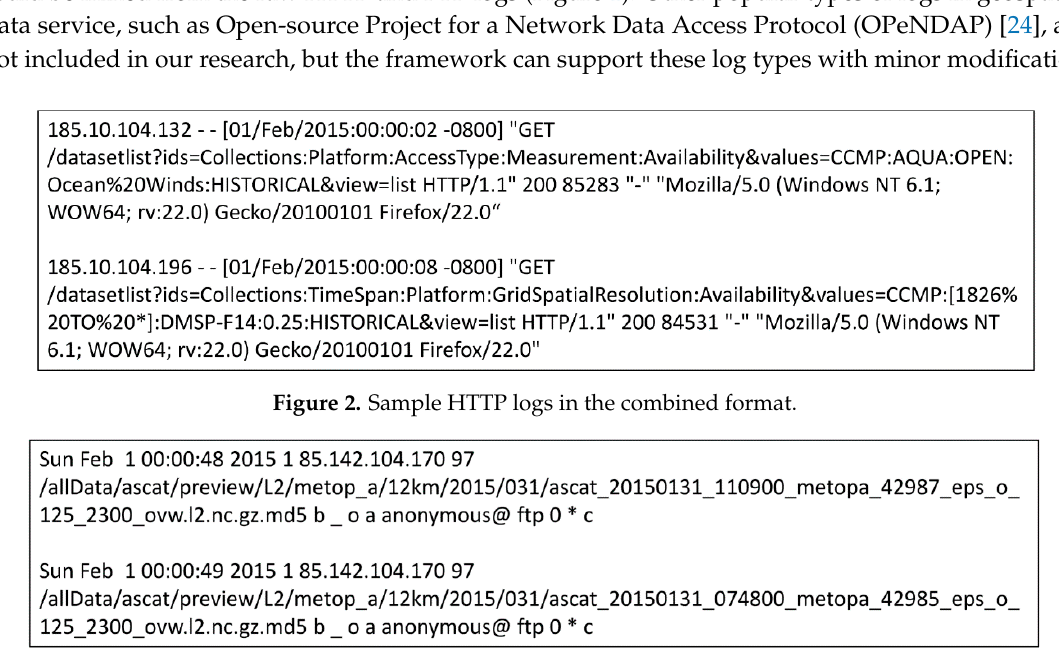
Figure 3. Sample FTP log data in FTP format.